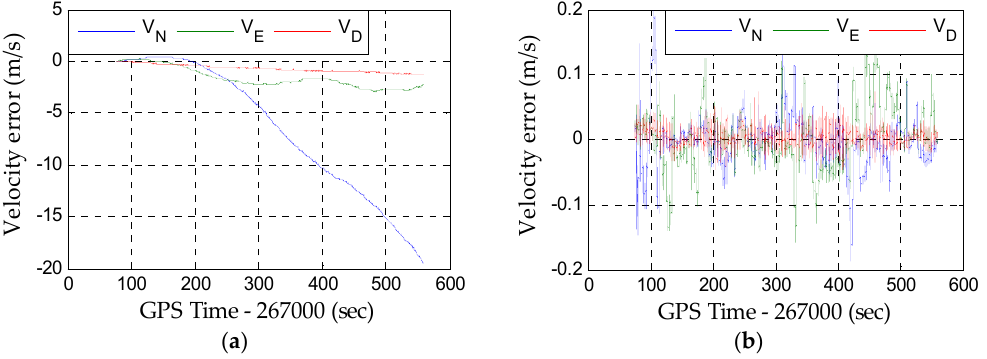
Figure 14. Velocity error in the north (V N ), east (V E ), and down (V D ) directions. ( a ) INS-only solution; ( b ) Vision-aided INS solution.